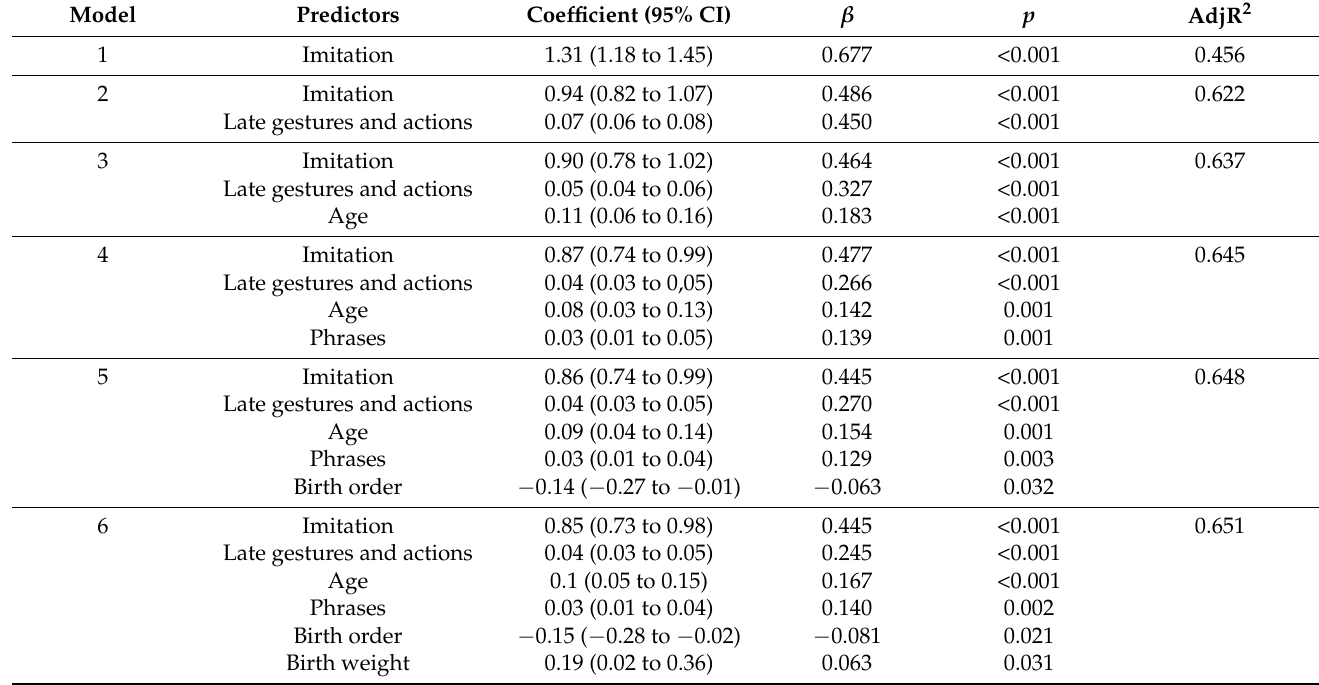
Table A1. Statistics from the stepwise regression